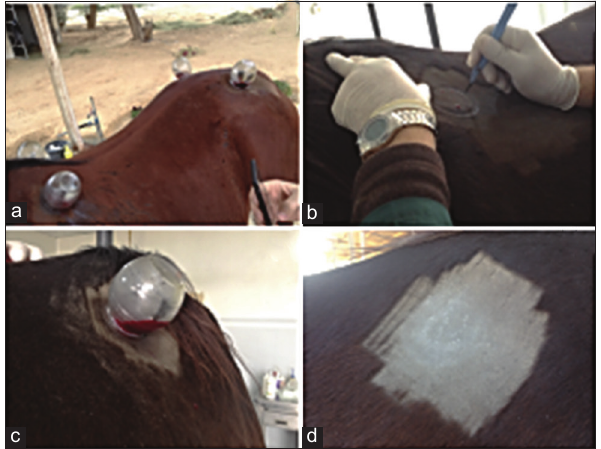
Figure-1: (a) Image showing the position of cupping in horses two places located behind the shoulder (left and right) and the other two places located on the rump (left and right) in the level of sacrum; (b) Uses a blade to make some superficial incisions on cupping areas; (c) Bleeding in progress into the glass cups after incising the skin with a blade. (C and d) Place of wet cupping therapy (7 days after cupping